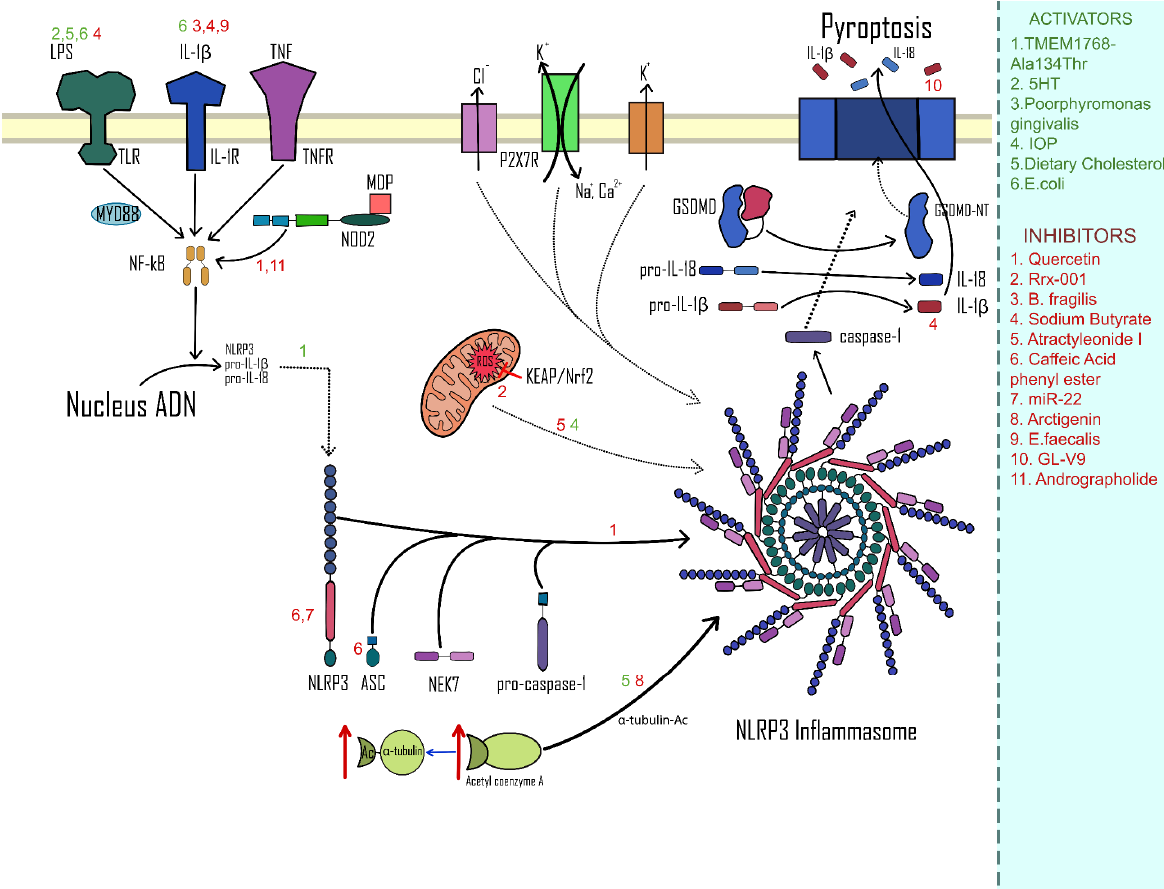
Figure 2. Pathways of activation/inhibition of the NLRP3 complex in CA-CRC.